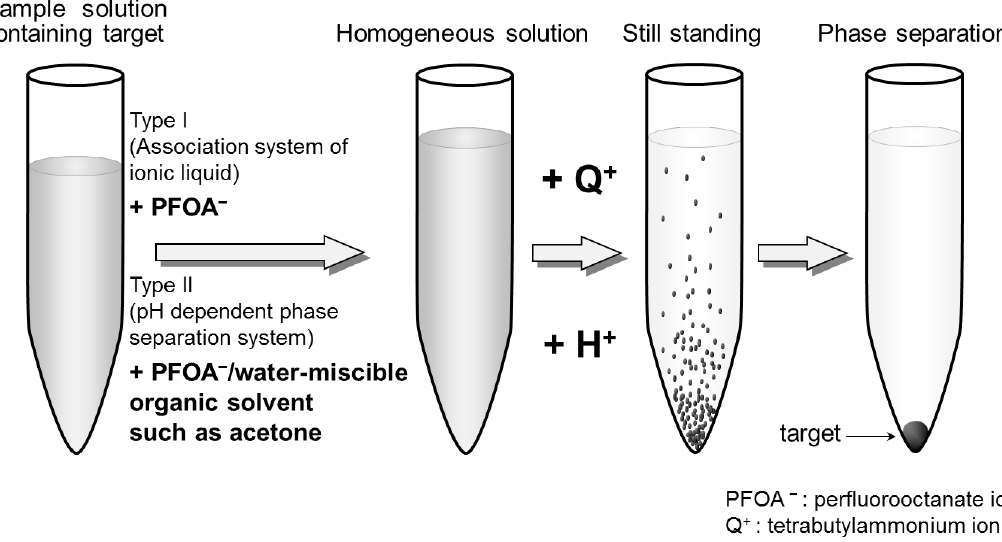
Figure 1. Scheme of homogeneous liquid-liquid extraction method